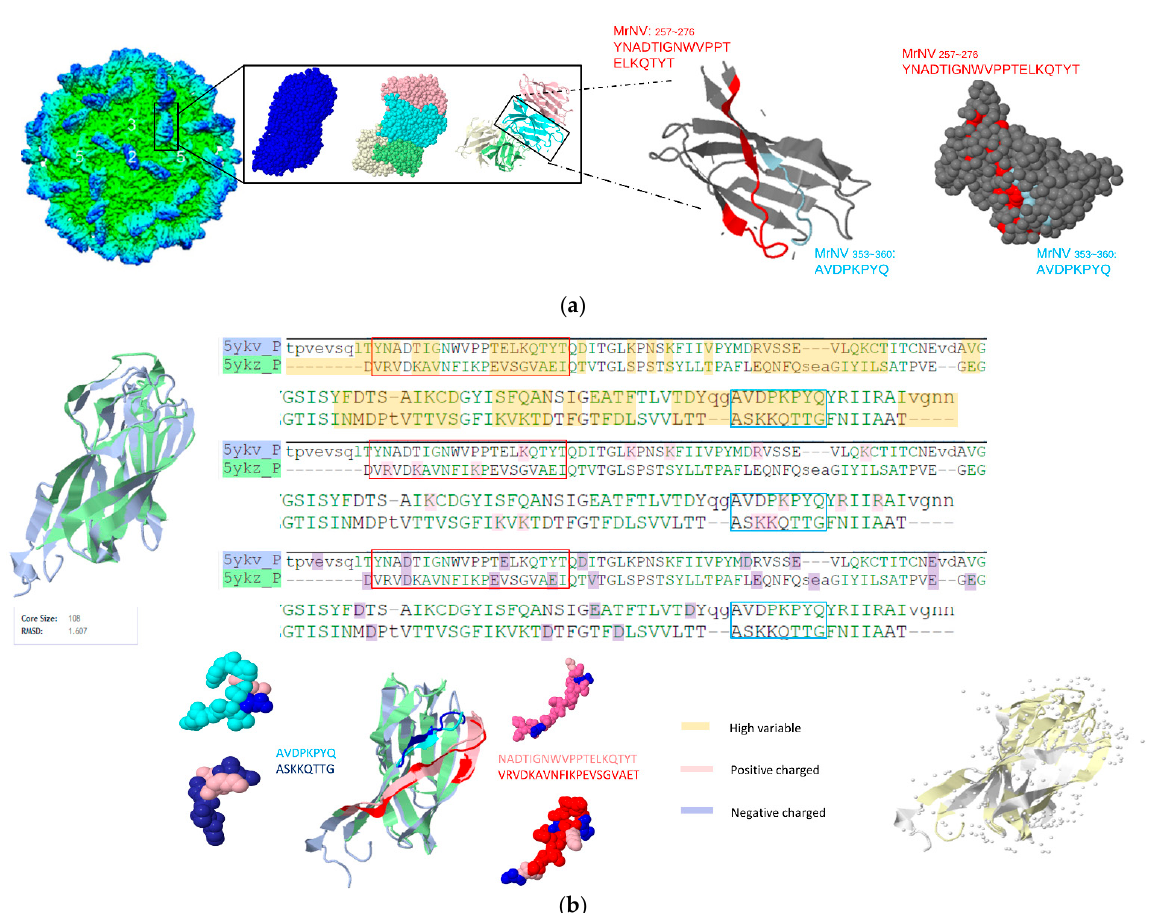
Figure 4. Predicted LEs for gammanodavirus and alignment between MrNV(PDB:5YKV) and PvNV(PDB:5YKZ). ( a ) Visualizing the predicted epitopes with space fill and cartoon style, each chain in a subunit and each epitope in a chain was represented by distinct color codes; ( b ) the P-domain of MrNV (PDB:5YKV) and PvNV (PDB:5YKZ) are structurally aligned by our own developed structural alignment system (AIR), represented by the following color codes: yellow (highly variable region), pink (positive-charged residue), blue (negative-charged residue).